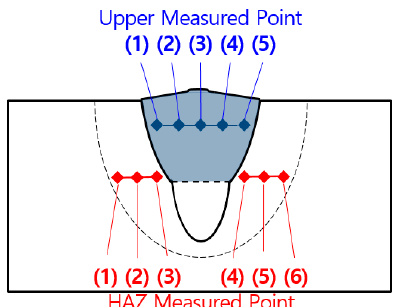
Figure 4. A schematic diagram of the hardness test. Table 6. Results of hardness according to welding process and parameters.